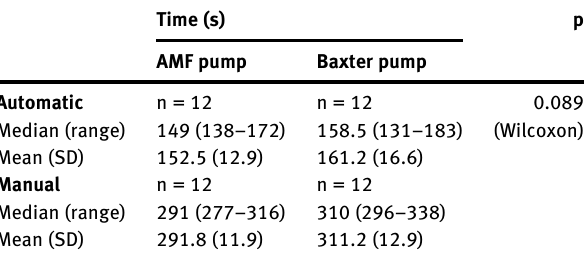
Table  : Automatic and manual fi lling times for AMF and Baxter elastomeric pumps.